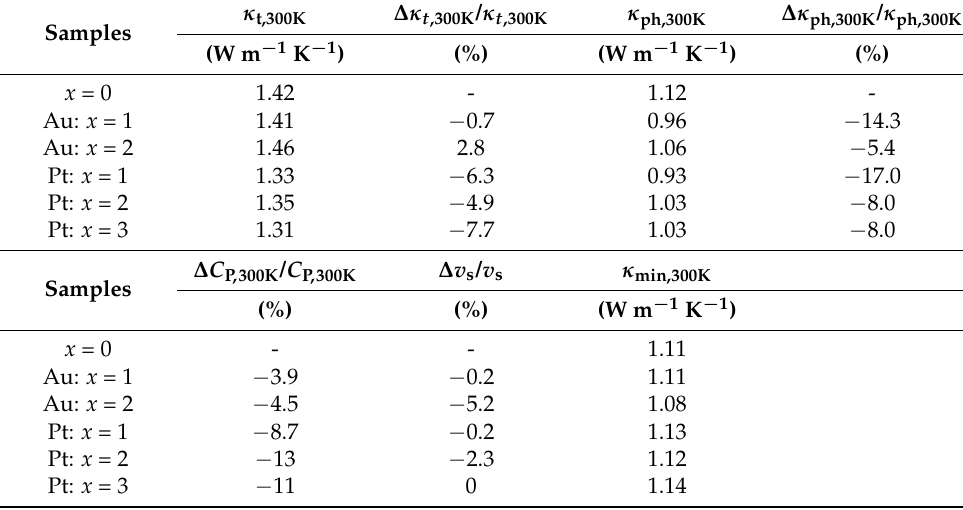
Table 3. Total thermal conductivity at 300 K ( κ t,300K ) and its rate of change ( ∆ κ t,300K / κ t,300K ), phonon thermal conductivity at 300 K ( κ ph,300K ) and its rate of change ( ∆ κ ph,300K / κ ph,300K ), rate of change in specific heat at 300 K ( ∆ C P,300K / C P,300K ), rate of change in speed of sound ( ∆ v s / v s ), and minimum thermal conductivity at 300 K ( κ min,300K ) for Al 63 Cu 25 − x (Au,Pt) x Fe 12 ( x = 0, 1, 2, 3). Al 63 Cu 22 Au 3 Fe 12 is excluded because of secondary phase